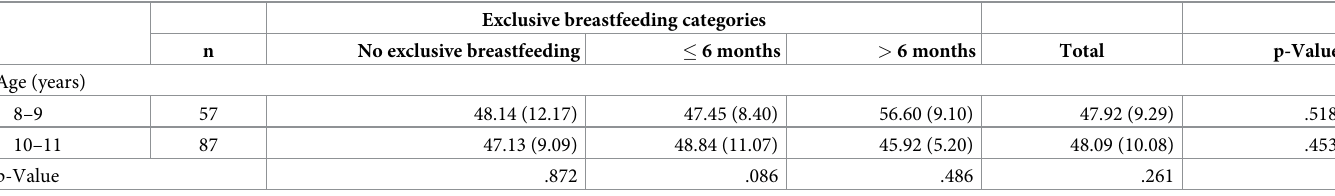
Table 3. Mean difference in BDNF levels by exclusive breastfeeding categories and